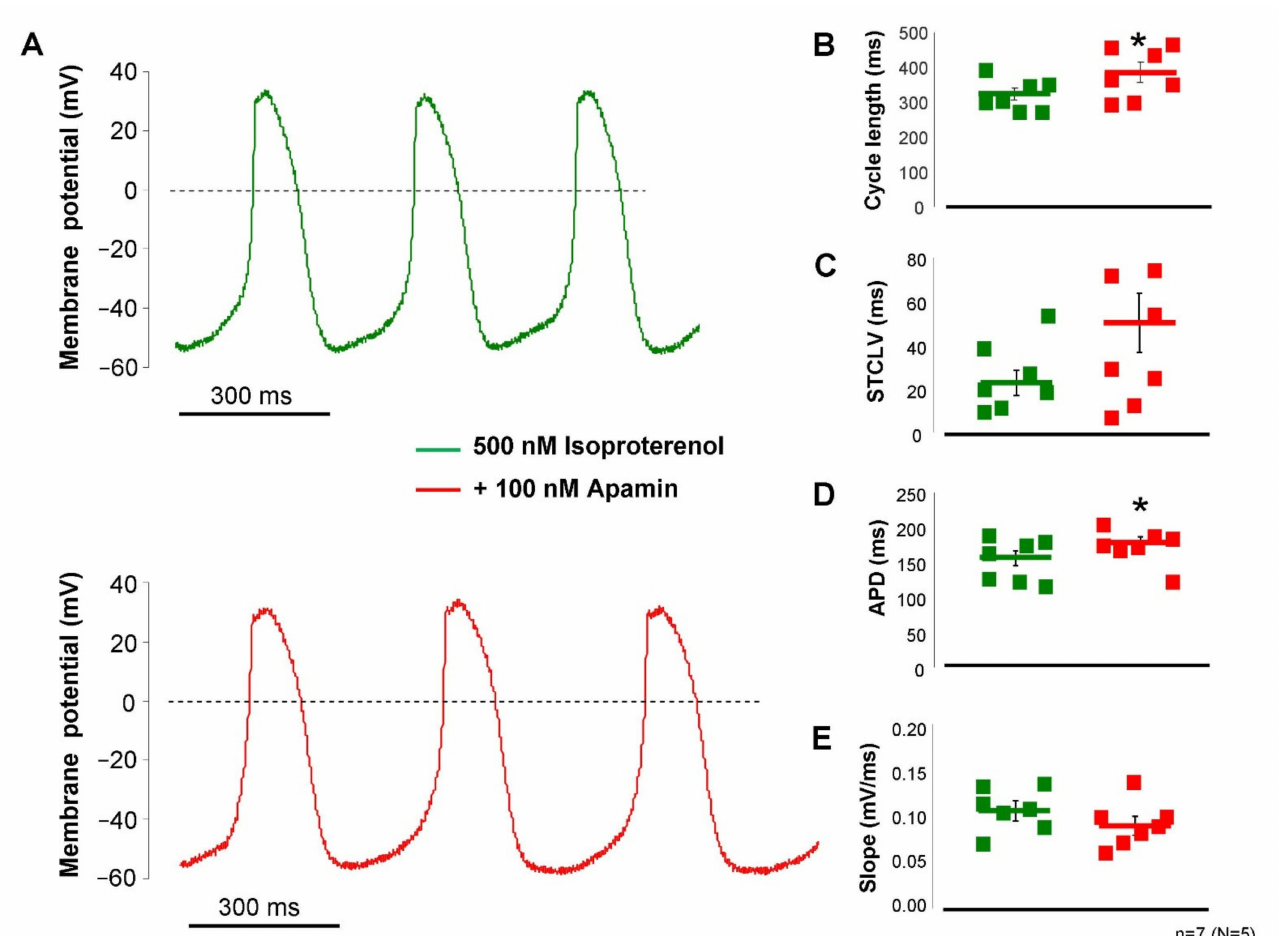
Figure 6. Action potential recordings from isolated SAN cells by perforated patch-clamp technique in the presence of 200 nM isoproterenol. The control recordings were measured in the presence of isoproterenol (green curve), then 100 nM apamin was employed (red curve, ( A )). Application of apamin increased the cycle length ( B ) without alteration of the short-term cycle length variability ( C ), and increased the APD ( D ) without changing the diastolic depolarization ( E ). Statistical analysis was performed by paired t -test ( p <